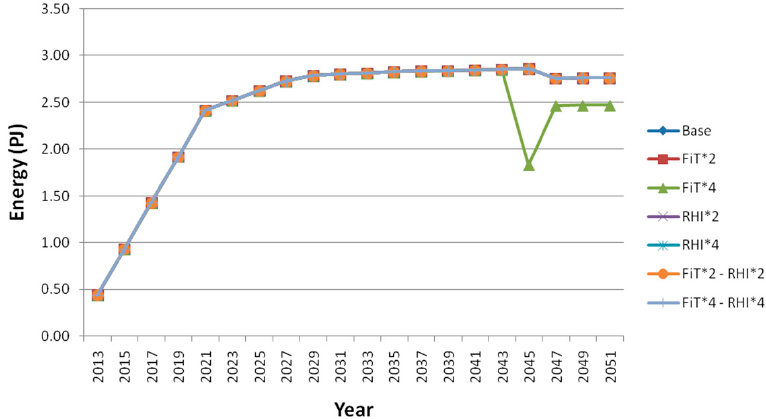
Figure 17. Specialist pig farms—biogas production.